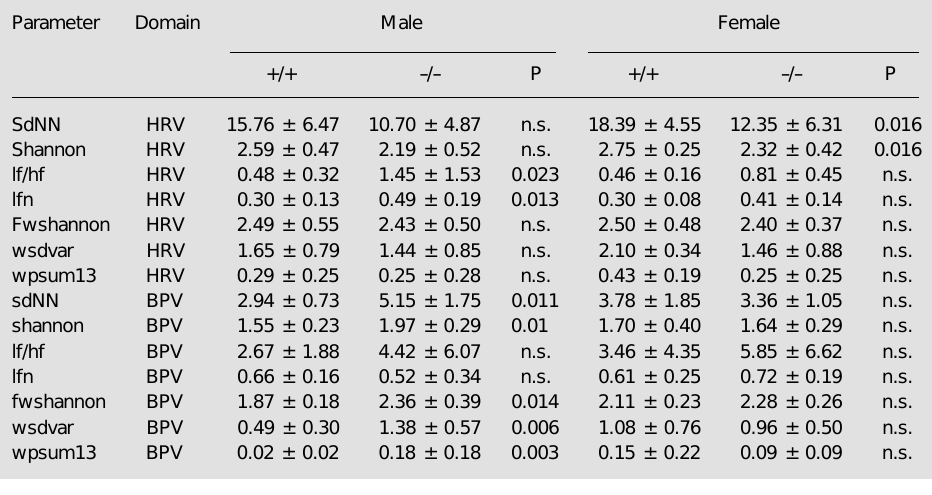
Table 2 - Parameters of heart rate variability (HRV) and blood pressure variability (BPV). Parameters of HRV and BPV in control (+/+) and Mas -deficient (-/-) animals specified by gender. Values are reported as means ± SD; P, statistical significance; n.s., nonsignificant.